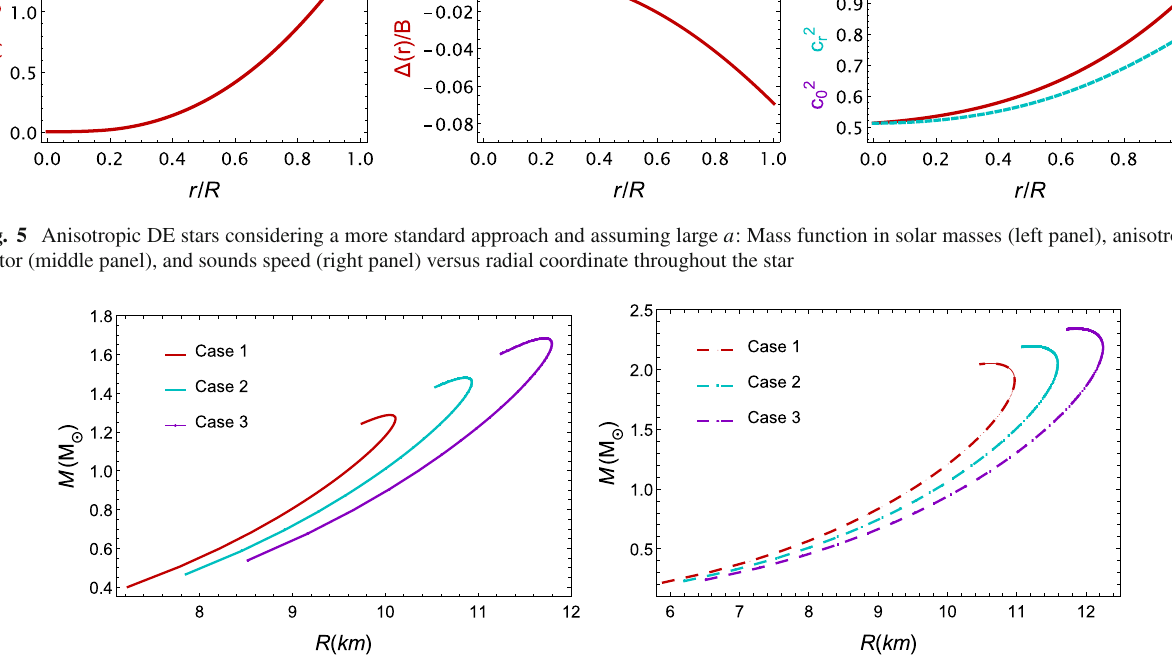
Fig. 6 Mass-to-radius profiles in two alternative approaches: Left: Profiles for the 3 models corresponding to the curves following the complexity formalism. Right: Profiles for the 3 models corresponding to curves obtained in the conventional